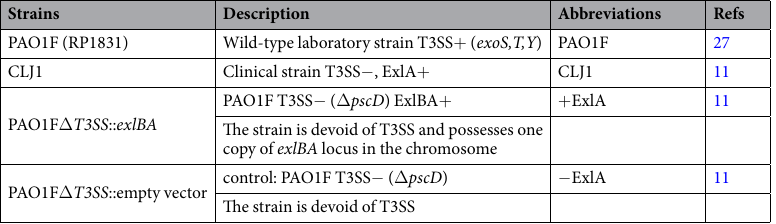
Table 1. P. aeruginosa strains used in this